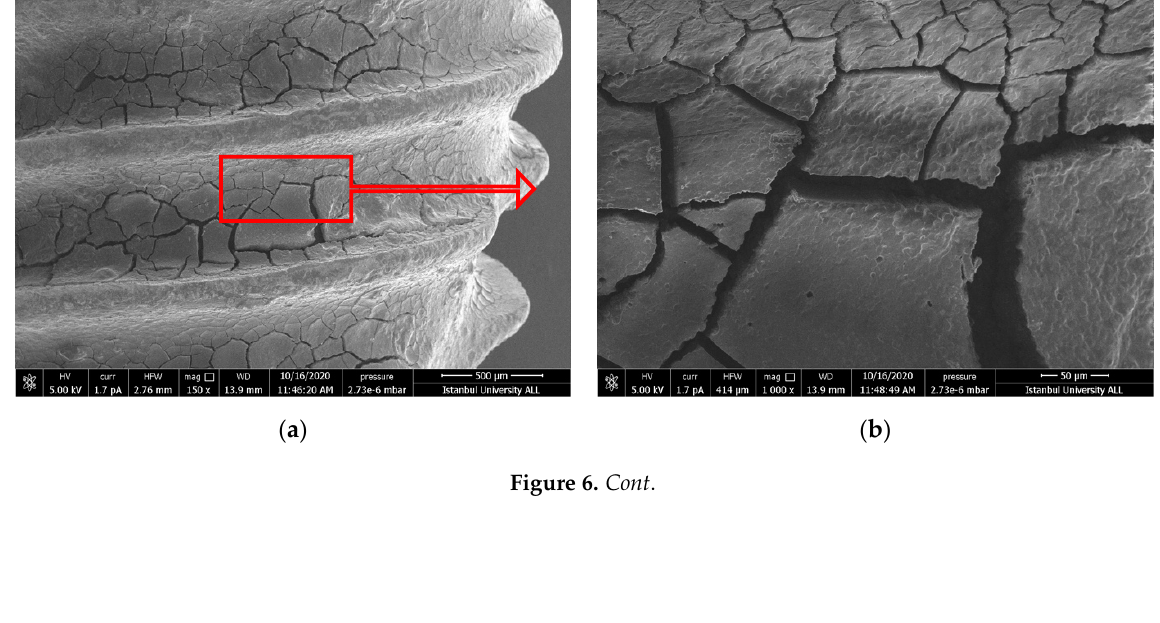
Figure 5. ( a , b ) SEM images showing the topography of untreated failed implant surfaces in ErL-LP group (150× and 1000×) ( c , d ) after intervention (150× and 1000×). Red arrows show the further magnification area.